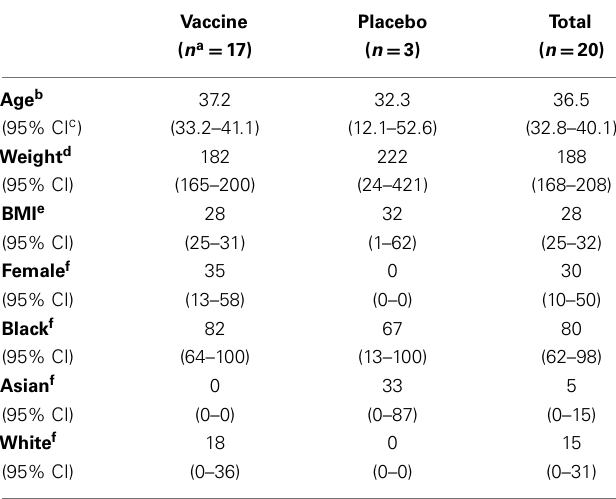
Table 1 | Summary of the demograpics of the volunteers recruited for the study